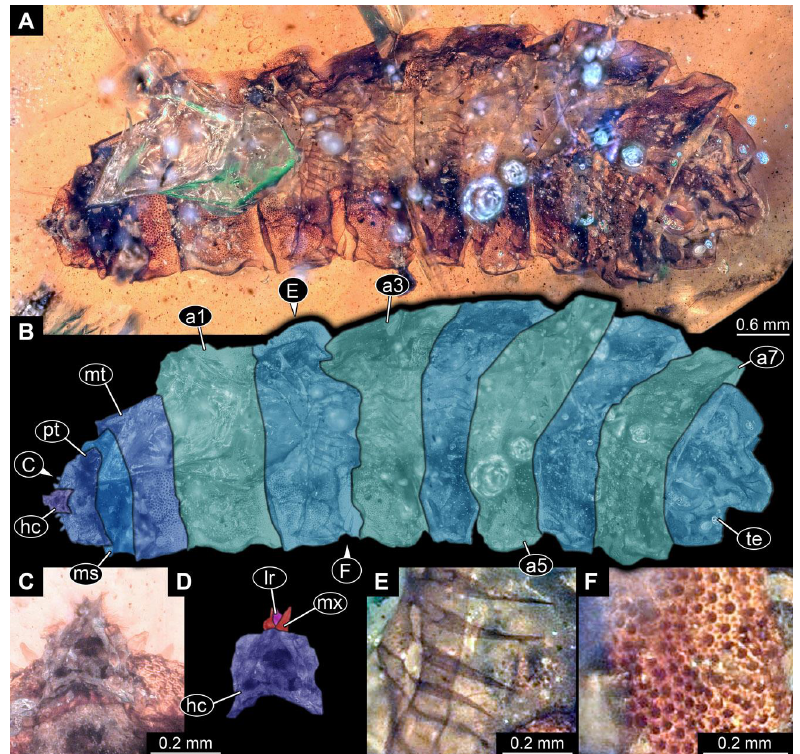
Figure 25. Fossil larva of morphotype 2 or 7, specimen PED 1254. ( A ). Ventral view. ( B ). Colour- marked. ( C ). Close-up of head capsule. ( D ). Close-up of head capsule, colour-marked. ( E ). Close-up of ventral spine-like setae. ( F ). Close-up of surface structure. Abbreviations: a1 – a7 = abdomen units 1 – 7; hc = head capsule; lr = labrum; ms = mesothorax; mt = metathorax; mx = mandibular – maxillary complex; pt = prothorax; te = trunk end. (125) PED 1262: Specimen accessible only in dorsal view (Figure 26). Numerous par- ticles, cracks and bubbles conceal details, surface structure apparent. Head capsule well preserved, slightly bent. Dimensions: body length 5.06 mm, body width 1.85 mm, head capsule length 0.55 mm, head capsule width 0.12 mm.